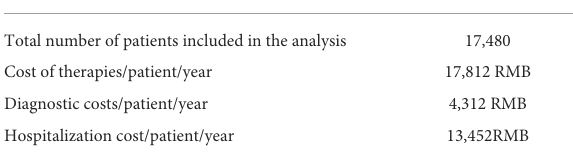
TABLE 5 Cost-related information of the enrolled